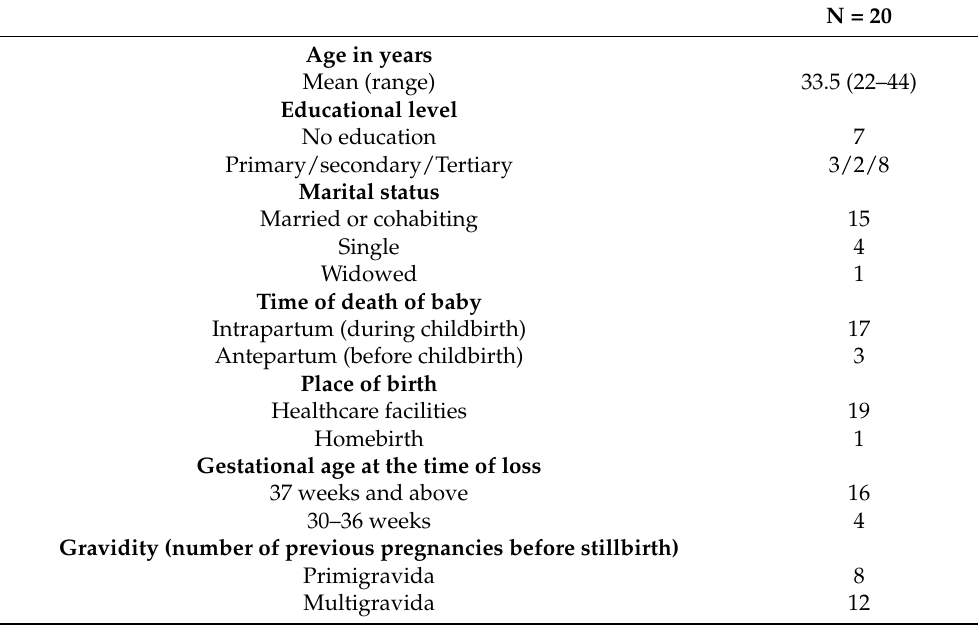
Table 1. Demographic characteristics of the study